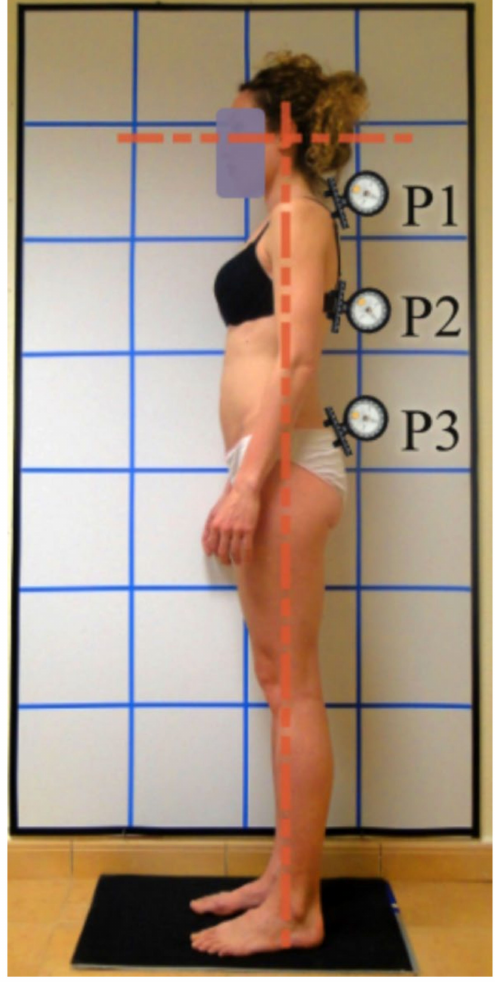
Figure 1. Vertebral curve quantification in the sagittal plane using an inclinometer. P1: Inclination of the cervical section, P2: Maximum kyphosis of the thoracic section, P3: Sacral